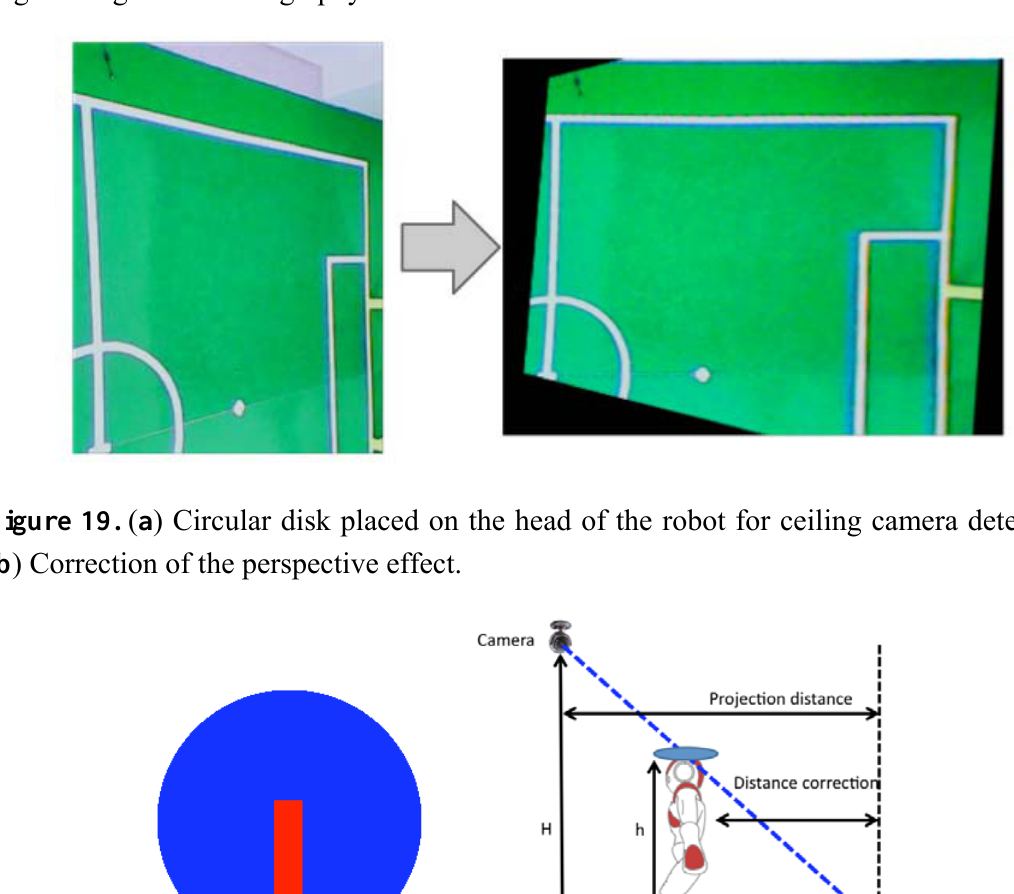
Figure 18. Perspective correction of the captured images. Left: original image, Right: image after homography.